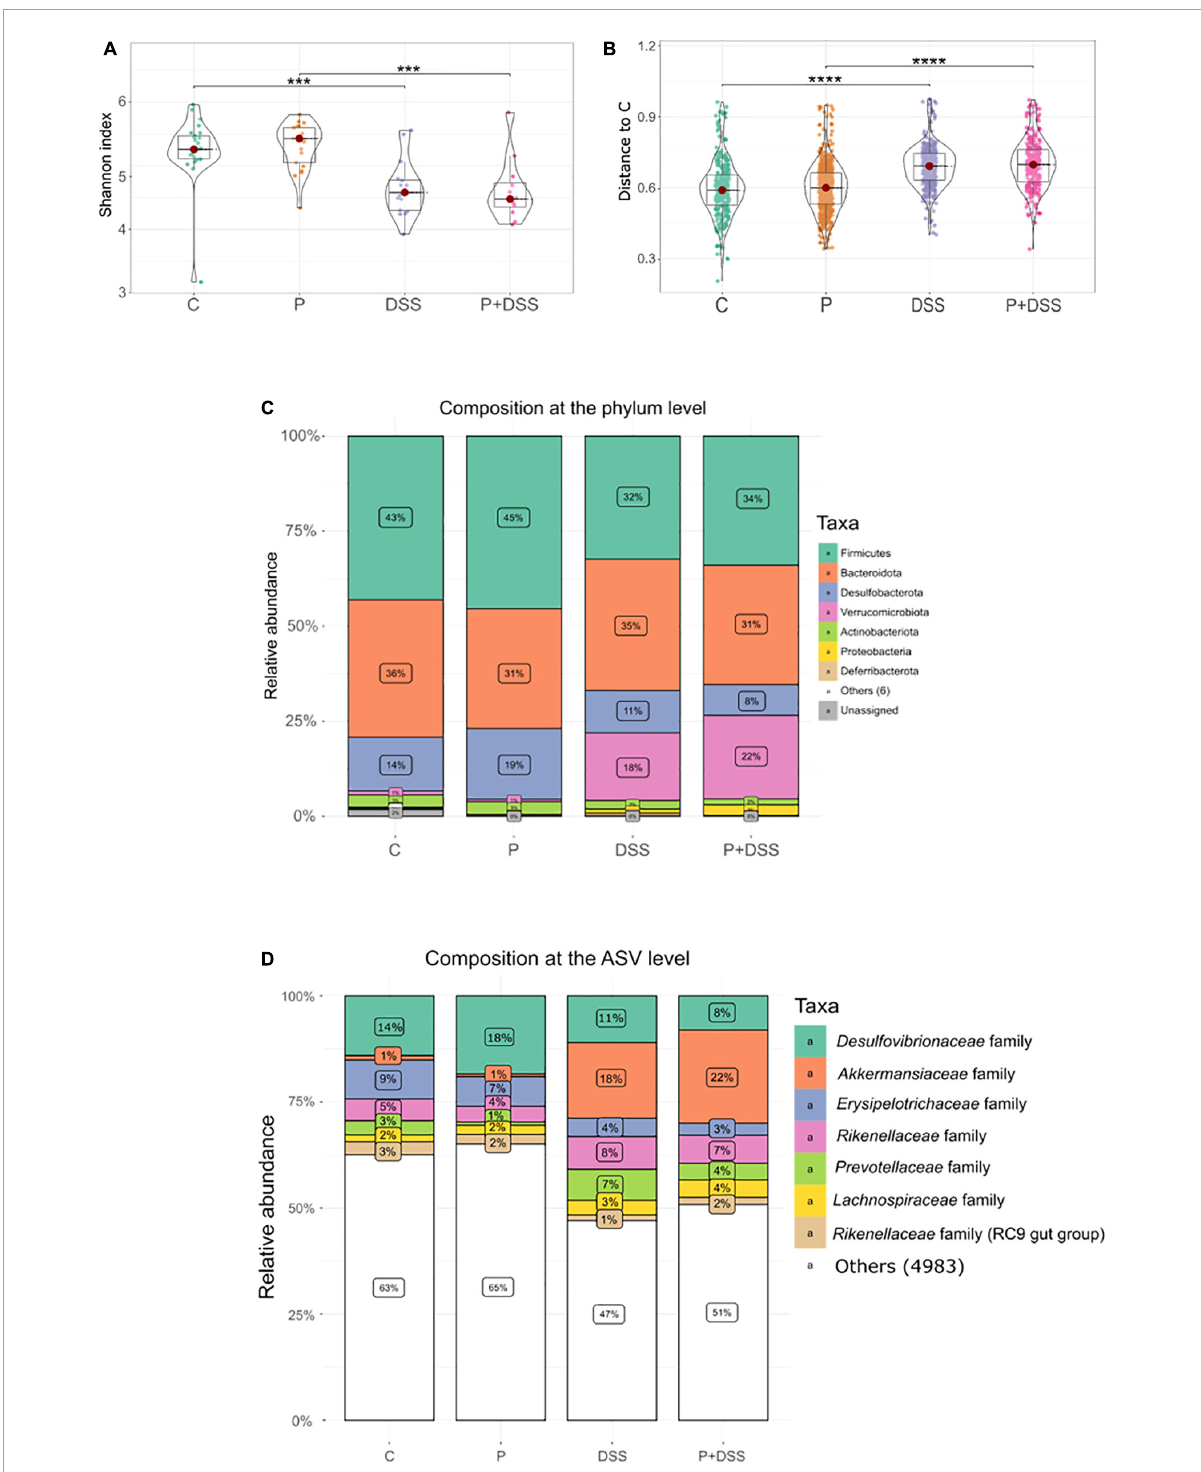
FIGURE5 Dextran sulphate sodium (DSS) treatment decreases the α -diversity and alters the β -diversity independent of the maternal prebiotic supplementation that slightly changes the relative abundance of phyla. Impact of prebiotics on bacterial diversities was measured in the distal colons of all groups of mice. (A) Alpha diversity is represented by the Shannon index. (B) Distance from all samples to C samples was expressed as the Bray–Curtis dissimilarity. Relative abundance of bacterial populations at (C) phylum level and at (D) amplicon sequence variant (ASV) level with family classification. Kruskal–Wallis test followed by Dunn’s post-test (A,B) : *** p < 0.001, **** p < 0.001 (DSS effect). N = 12–24 mice/group at the beginning of the